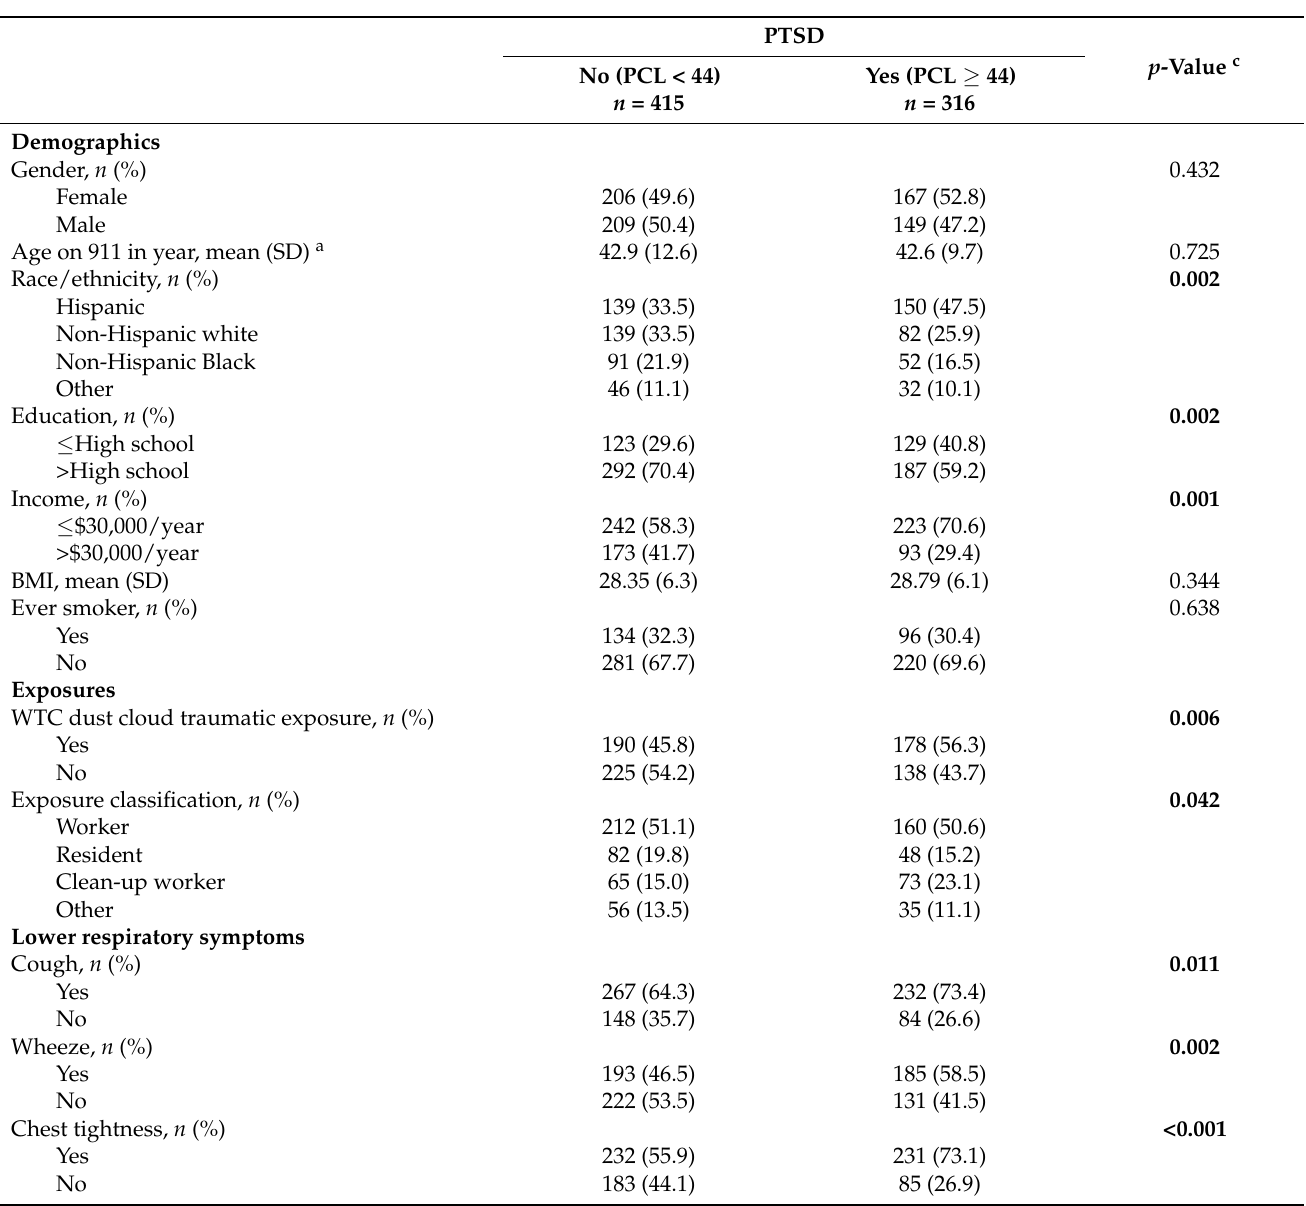
Table 2. Univariate analyses for association of PTSD with each of the predictors ( n = 731).